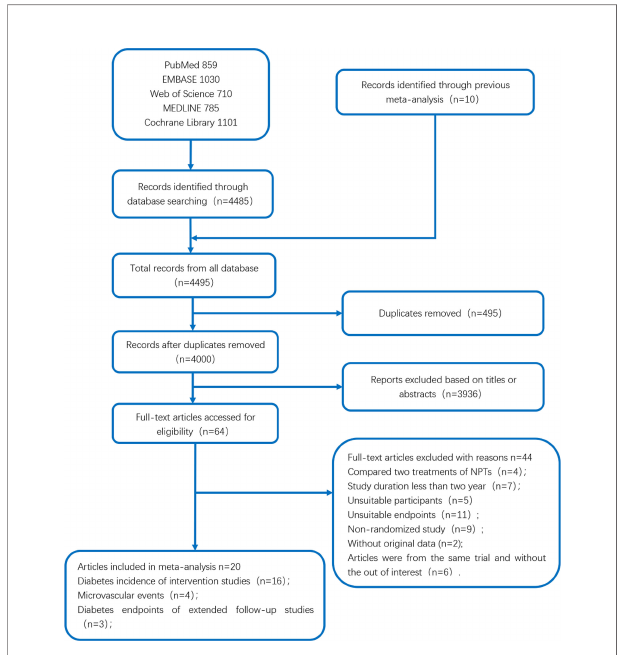
FIGURE 1 | The fl ow diagram of search and selection process used for studies included in the